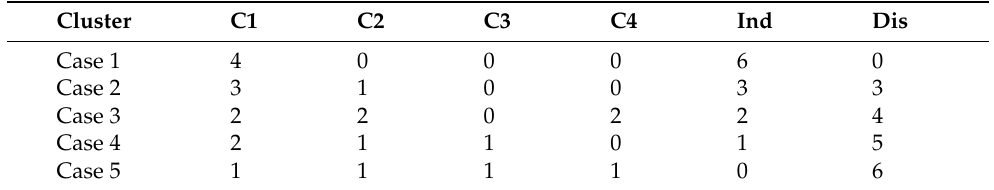
Table A1. Five possible clusterings with cluster number as four. “IND”: the number of indistinguish- able pairwise comparisons; “DIS”: the number of distinguishable pairwise comparisons. Cluster C1